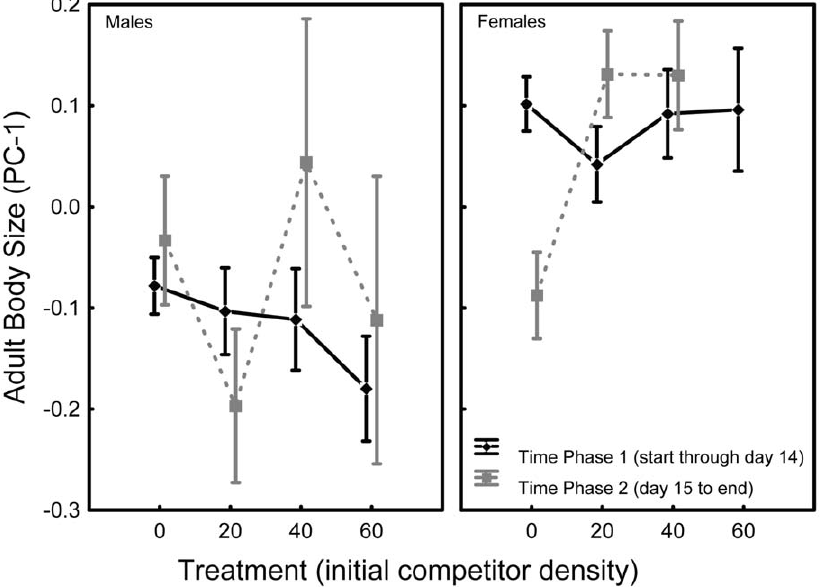
Figure 4. Sex-specific variation in adult size in the two emergence waves. O. caspius variation in body size with respect to time phase and treatment (initial larval combinations, ordered according competitor density). The two phases correspond with the two emergence waves described above (Fig. 2). Error bars denote 6 1S.E.